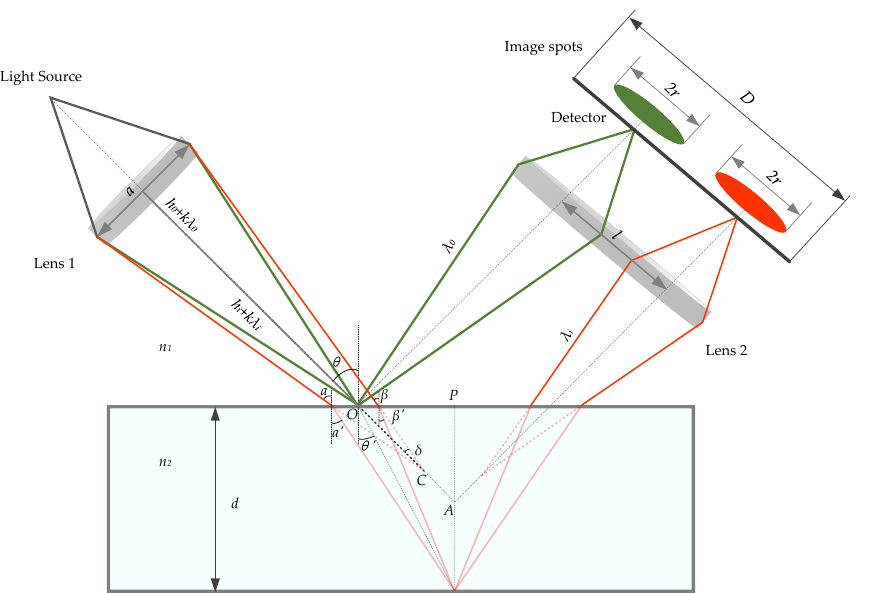
Figure 6. Thickness calculation model of a transparent specimen. The letters in the picture represent the following meanings: n 1 : the refractive index of the air; n 2 : the refractive index of the transparent specimen; λ 0 : the wavelength of green light; λ i : the wavelength of red light; h 0 + k λ 0 : the distance between point O and the lens 1; h 0 + k λ i : the distance between point C and the lens 1; a : the diameter of lens 1; d : the thickness of the transparent specimen; D : the imaging size of detector imaging surface; r : the radius of the image spots; l : the center distance of the imaging spots; θ : the inclined angle of the system; θ (cid:48) : the inclined angle of the system after refraction; δ : the optical axis of incident light and light beam with wavelength λ i ; α : the incidence angle of the left light beam with wavelength λ i ; α (cid:48) : the refraction angle of the left light beam with wavelength λ i ; β : the incidence angle of the right light beam with wavelength λ i ; β (cid:48) : the refraction angle of the right light beam with wavelength λ i